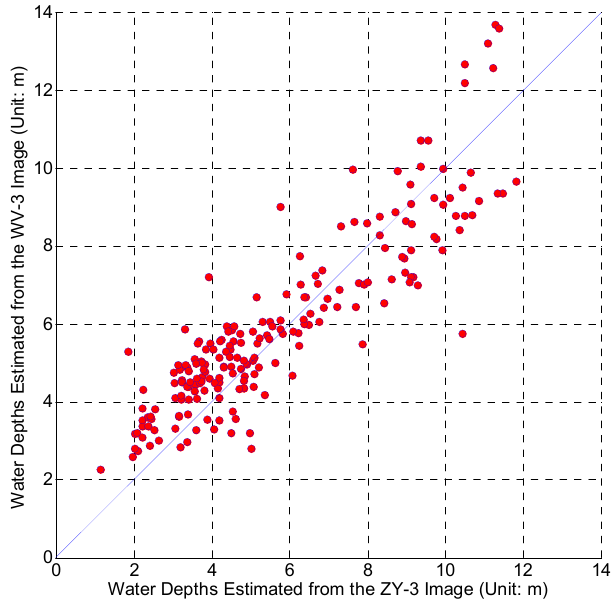
Figure 12. The Comparisons between the water depths estimated from the ZY-3 and the WV-3 images.